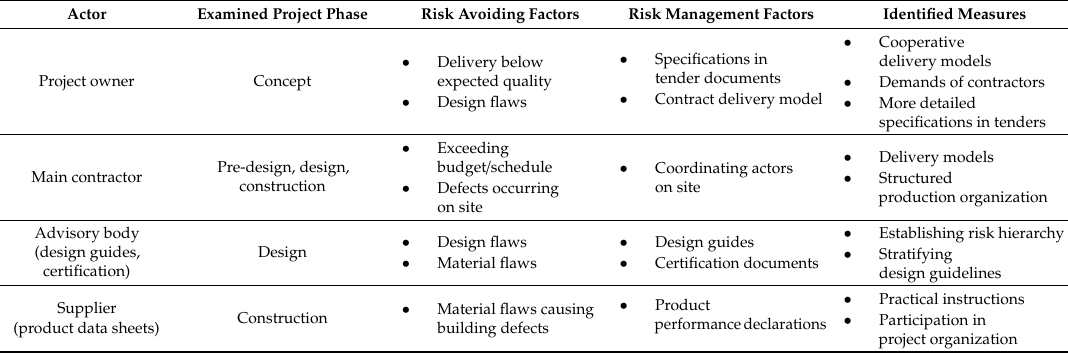
Table 1. Summary of the main findings. The column “Identified measures” refers to measures discussed in the Discussions chapter, Section 5.3 of this